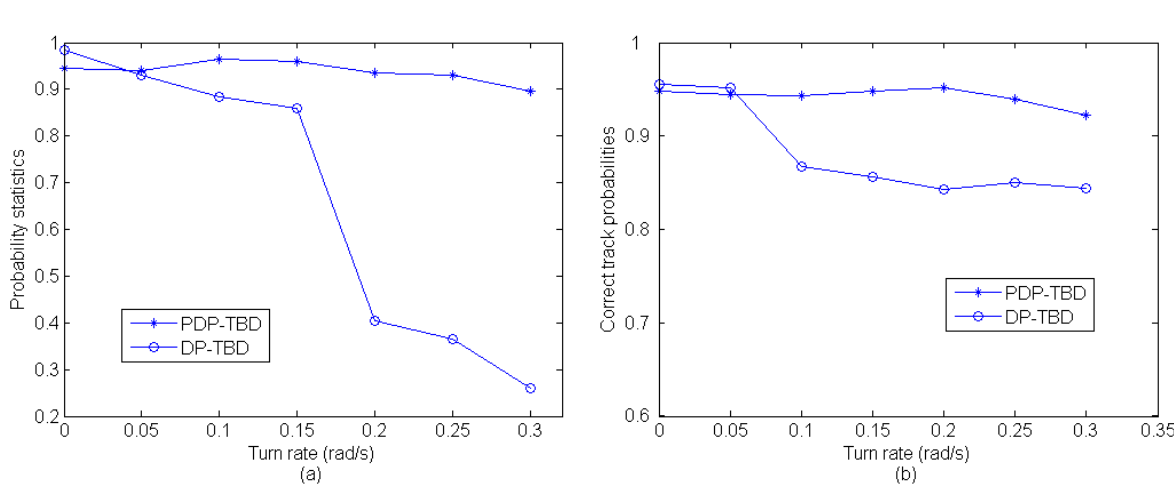
Figure 9. Comparison of the performances of the algorithms (200 runs) ( a ) Comparison of the probabilities of correct target number estimation; ( b ) Comparison of the correct track probabilities.